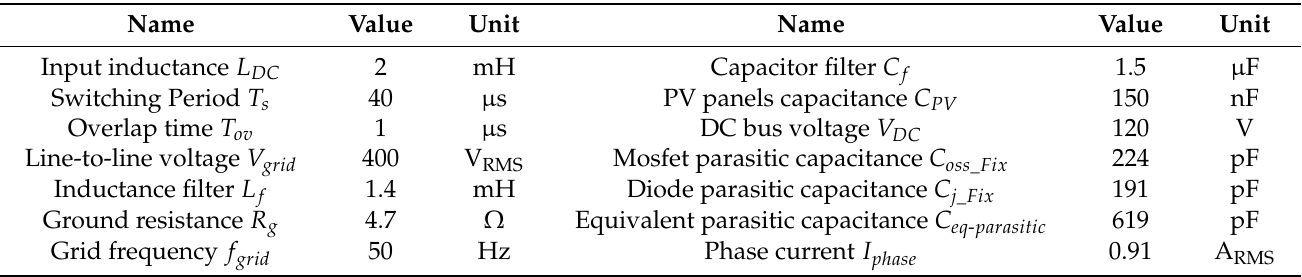
Table 1. Simulation